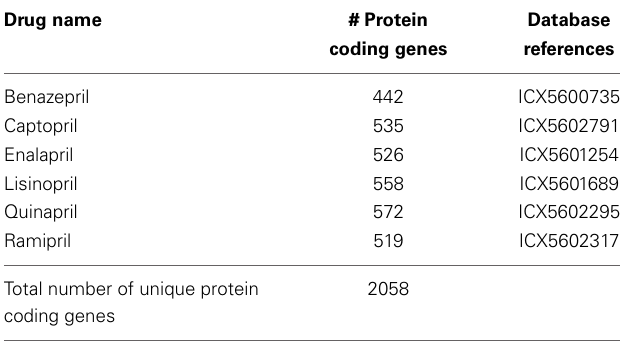
Table 2 | Drug mechanism of action data